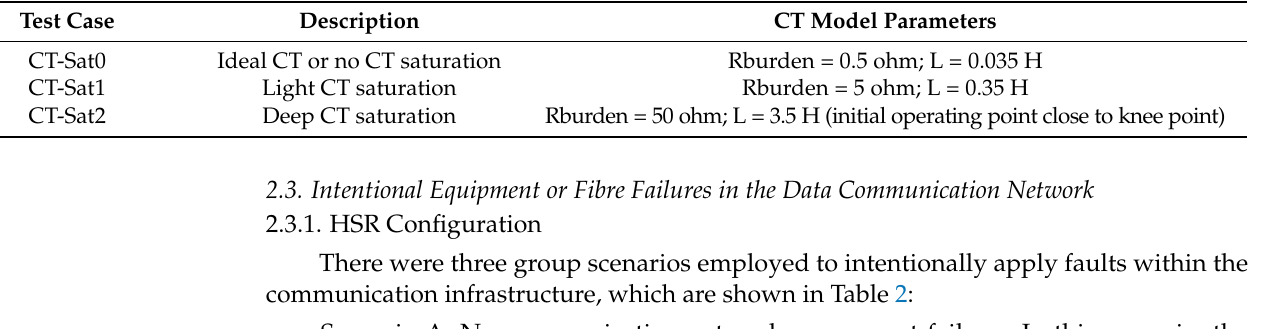
Table 1. CT saturation test cases.